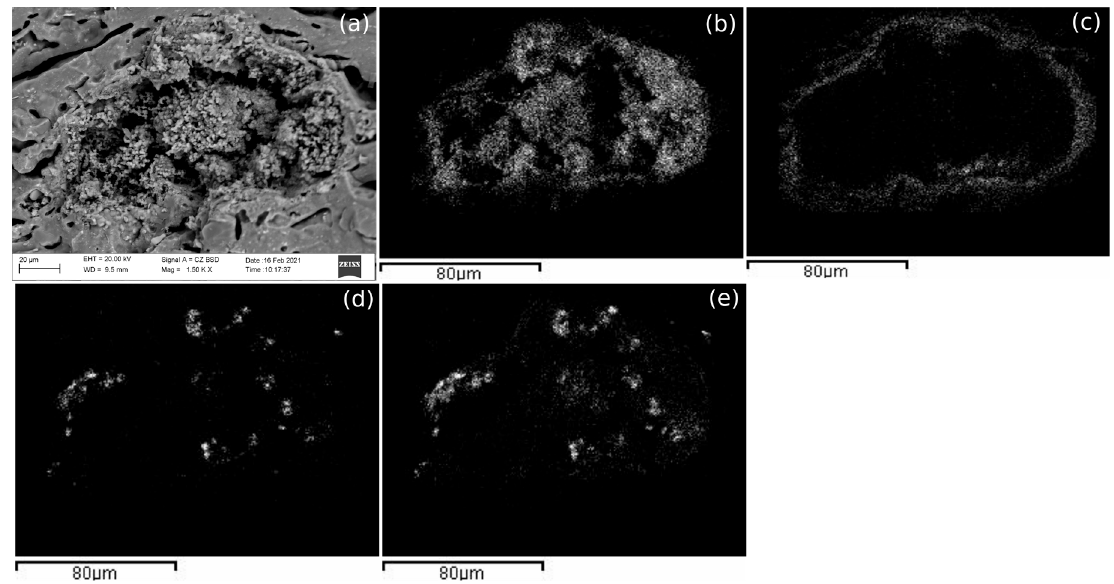
Figure 9. ( a ) SEM-BSD image of an aggregate present in AP016; ( b ) elemental mapping: the distribution of Mg in the aggregate of ( a ); ( c ) elemental mapping: the distribution of Ca in the aggregate of ( a ); ( d ) elemental mapping: the distribution of Na in the aggregate of ( a ); ( e ) elemental mapping: the distribution of Cl in the aggregate of ( a ).